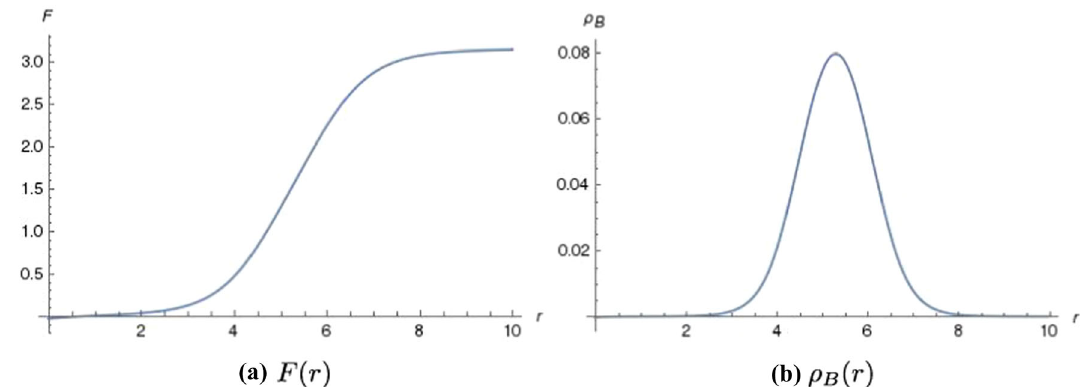
Fig. 5 Solution with n = 0